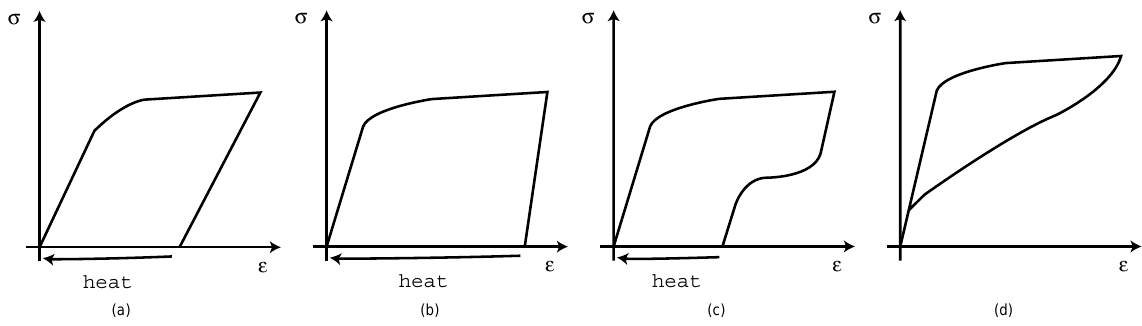
Fig. 1. Mechanical behavior of the shape memory alloy. ξ 0 indicates the initial phase state (martensite fraction) for each case (a) T < A s , ξ 0 = 1 (b) M s < T < A s , ξ 0 = 0 (c) A s < T < A f , ξ 0 = 0 (d) T > A f , ξ 0 = 0 [3].